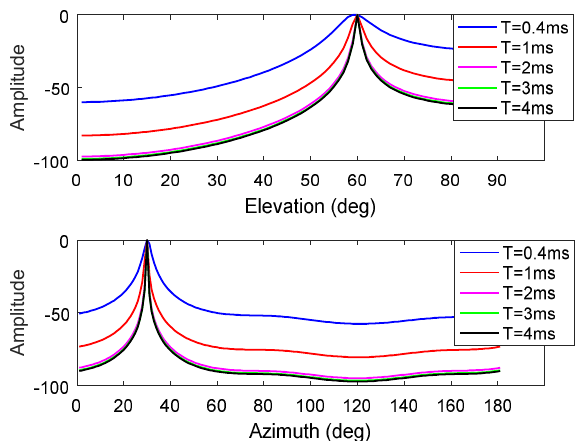
Figure 4. Estimation results for elevation and azimuthal angles obtained under different data block length conditions. (Top: The corresponding elevation angle spectrum function curves when the azimuthal angle is 30°; Bottom: The corresponding azimuthal angle spectrum function curves when the elevation angle is 60°).